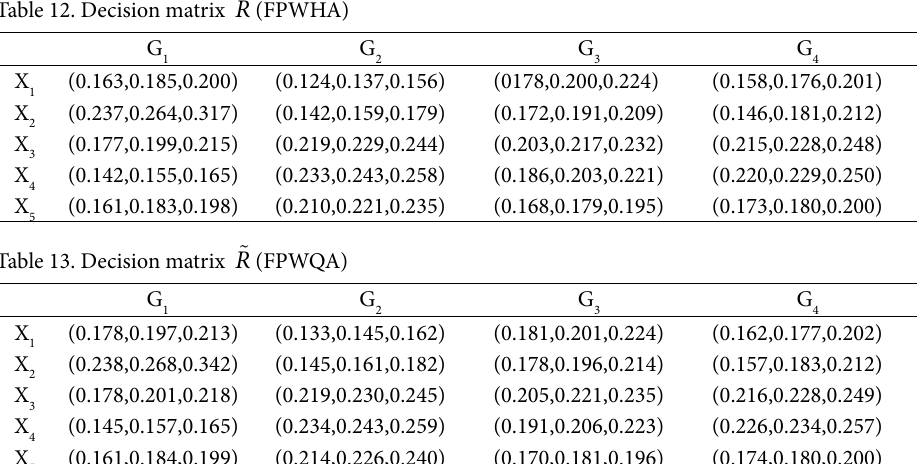
Table 12. Decision matrix R  (FPWHA)